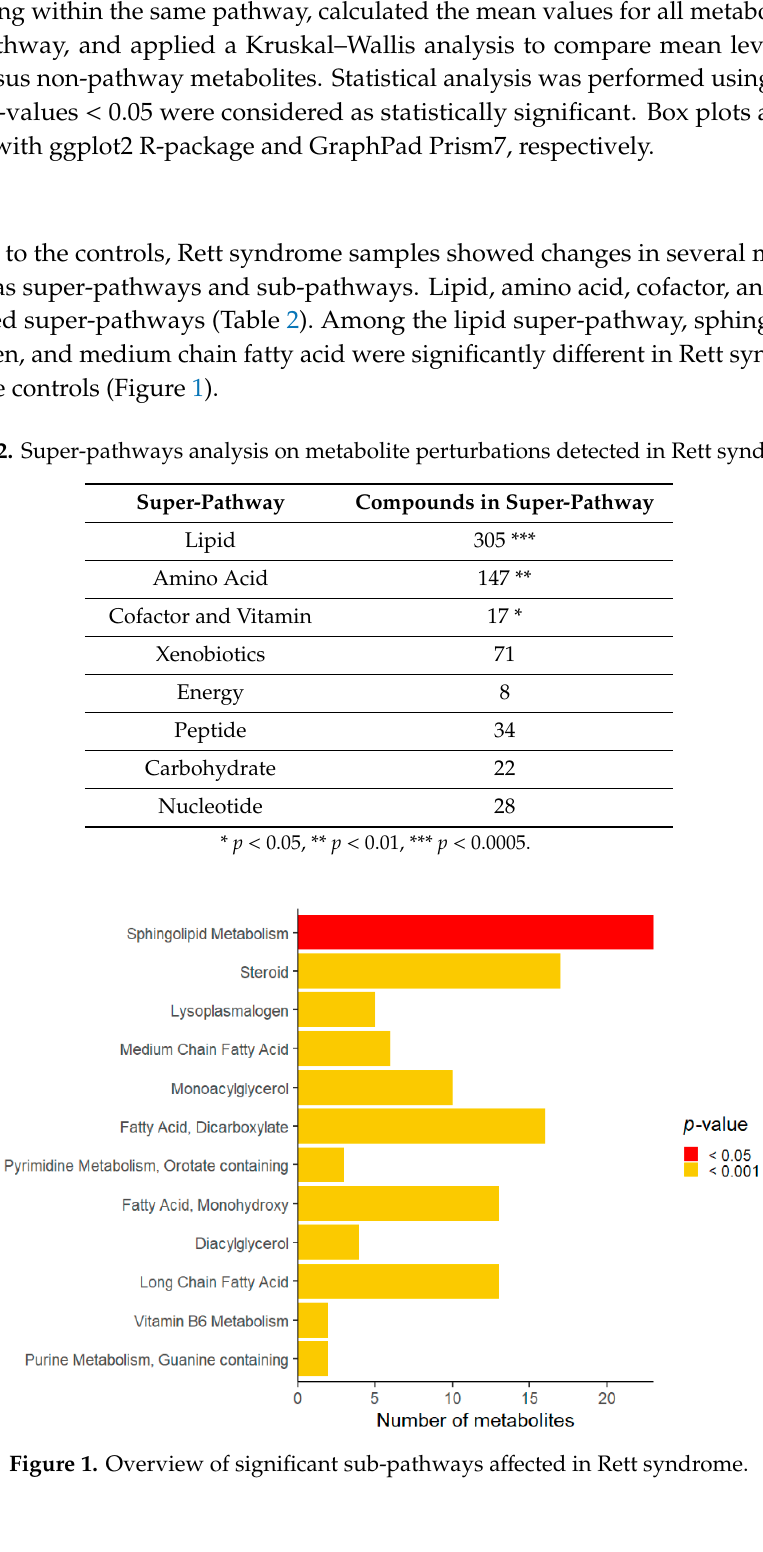
Figure 1. Overview of significant sub-pathways affected in Rett syndrome.